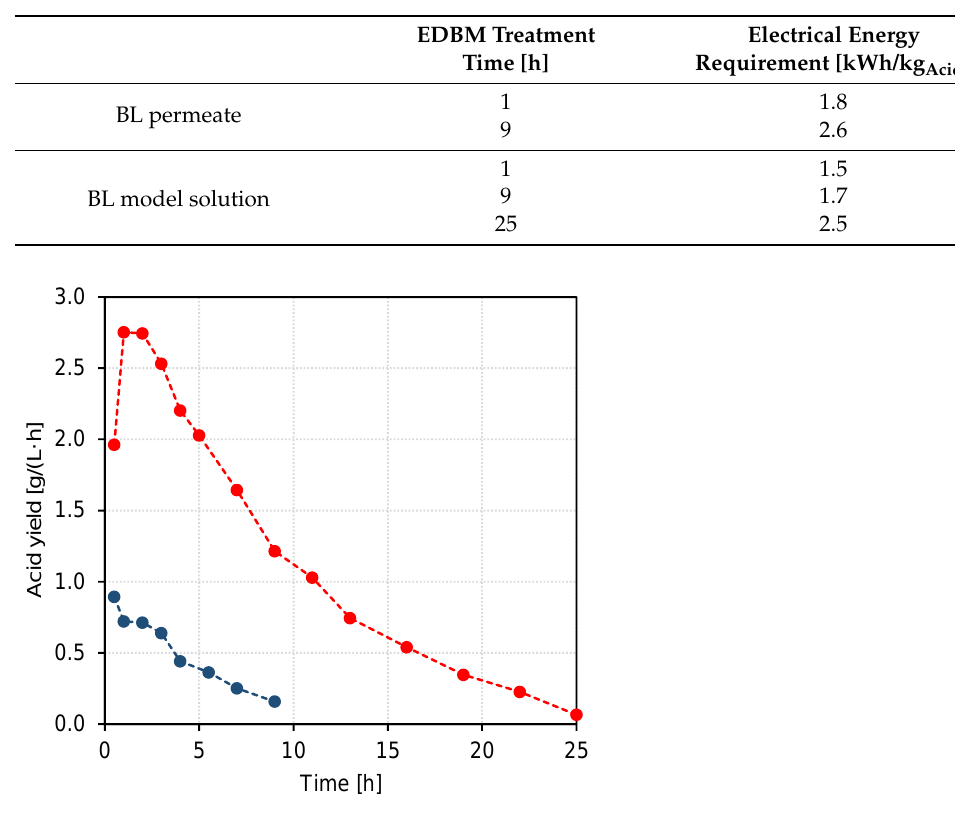
Table 3. Electrical energy requirement for the EDBM experiments with BL permeate and BL model solution after different treatment times for recovery of total carboxylic acids.